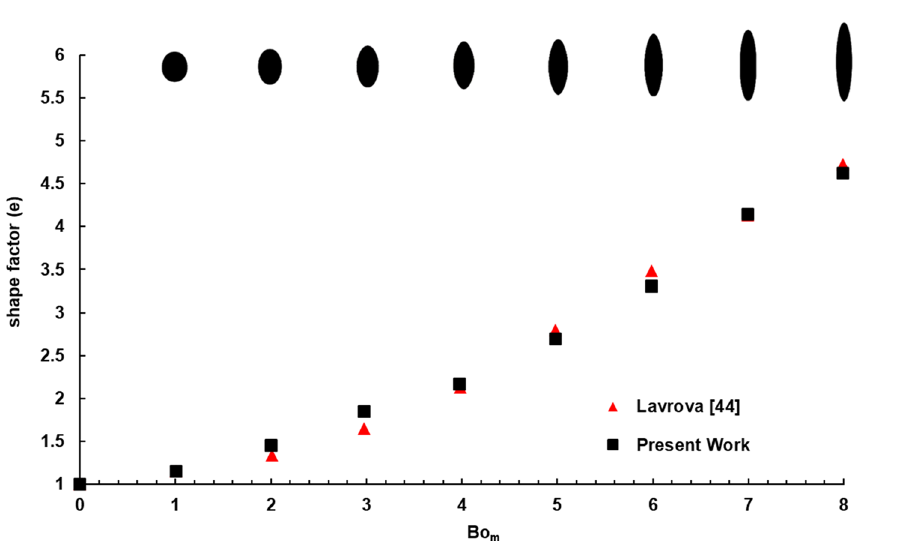
Figure 4. Variations of shape factor (the ratio of the major to the minor axis), e, in terms of the magnetic Bond number using the present numerical method and Lavrova results 48 . The shapes of the droplet in the equilibrium state are shown using the present numerical solution for different magnetic Bond